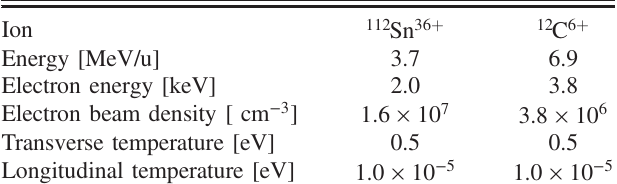
TABLE IV. The parameters used in the simulation for